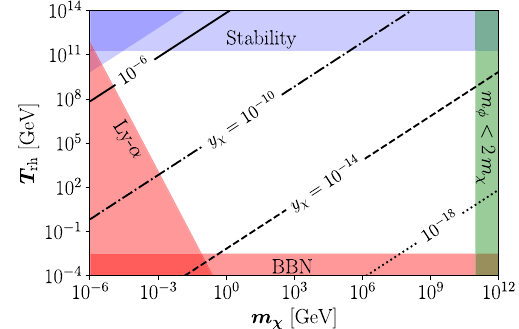
Fig. 4 Yukawa coupling y χ required to reproduce the whole observed DM abundance via the direct decay of the inflaton. The colored bands correspond to the different constraints described in the text. The white region is the allowed parameter space with 10 − 21 (cid:2) Br (cid:2) 10 − 4 and O ( 10 − 5 ) GeV (cid:2) m χ (cid:2) O ( 10 11 )